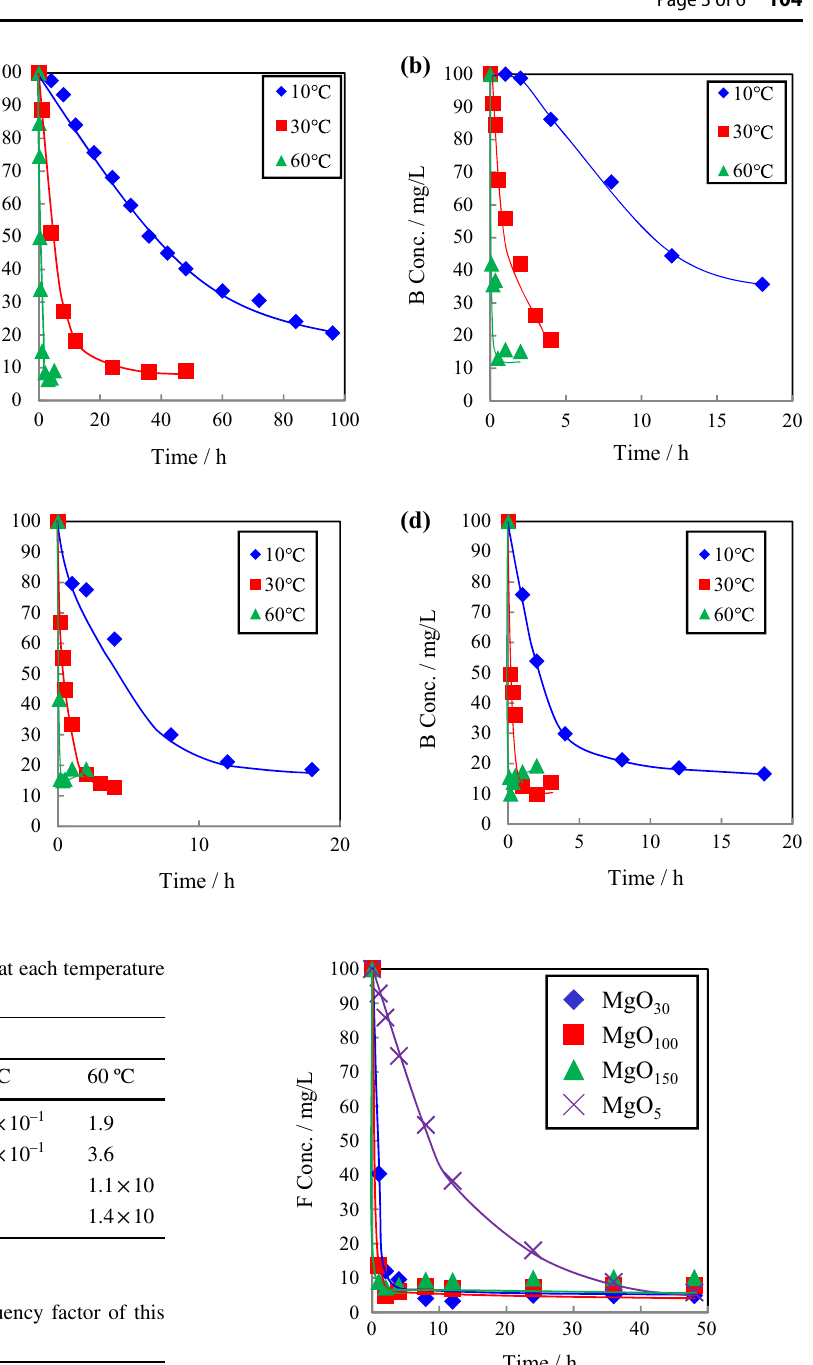
Fig. 3 Effect of specific surface area on the fluorine removal using MgO (Amount of MgO: Mg/F = 10, 30